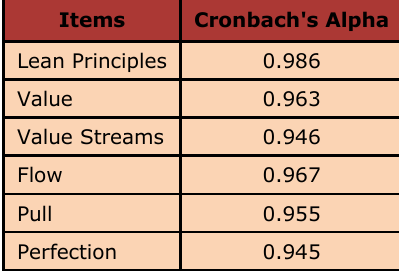
Table 5. Overall lean principles Cronbach’s